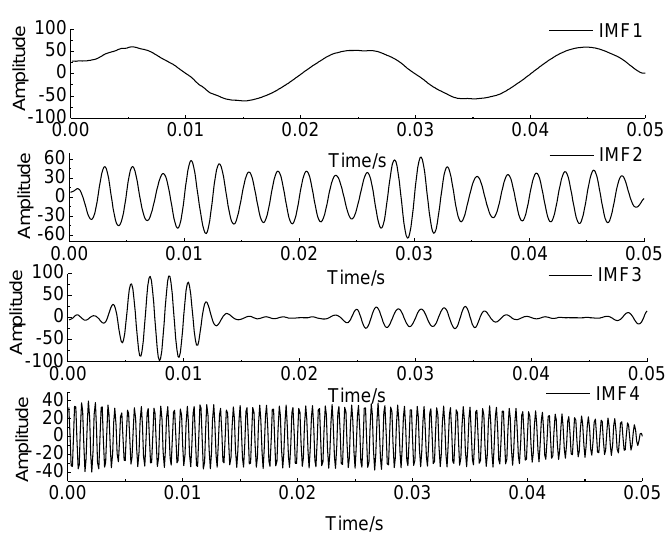
Figure 3. Optimized-variational mode decomposition (VMD) results of simulation signal y ( t ) .